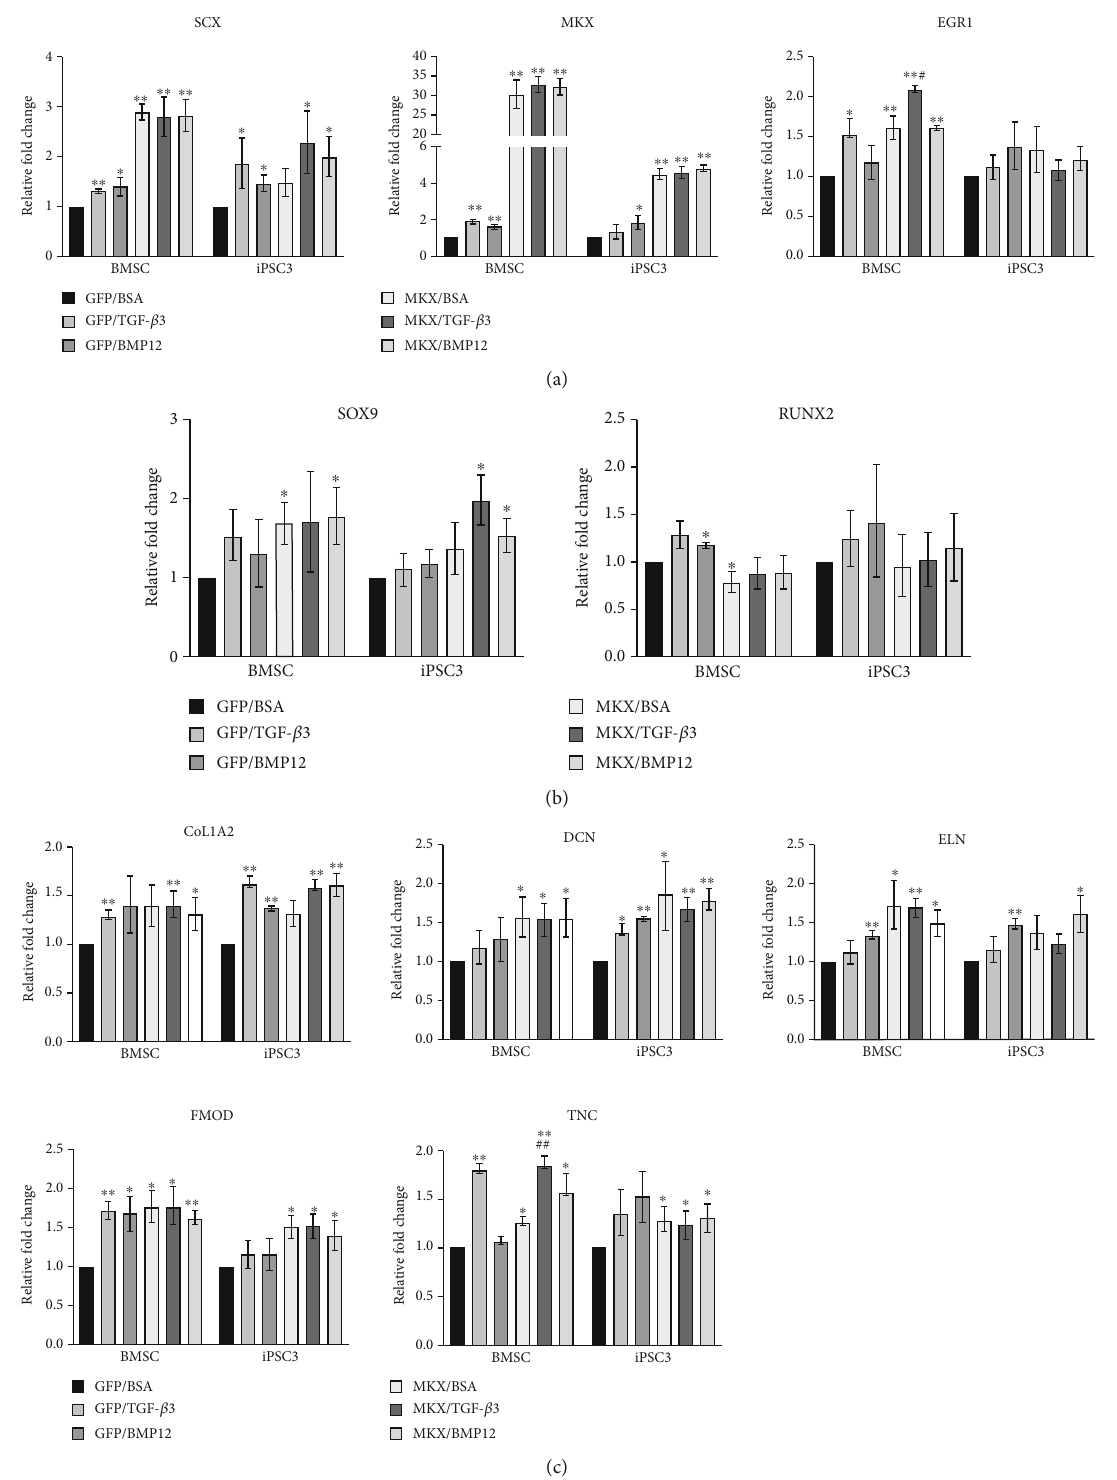
Figure 4: E ff ects of TGF- β 3 or BMP12 on tenogenic gene expression in MKX-overexpressing BMSCs and teno-iPSCs. Cells expressing GFP or equine Mohawk were treated with vehicle medium (GFP/BSA and MKX/BSA), TGF- β 3 (20 ng/mL, GFP/TGF- β 3 and MKX/TGF- β 3), or BMP12 (20 ng/mL, GFP/BMP12 and MKX/BMP12) for 5 days. cDNA was synthesized from total RNA, and expression of tenogenic transcription factors (a), SOX9 and RUNX2 (b), and tenocyte-related ECM genes (c) was determined by qPCR. Relative fold change for each group was calculated by comparison to the GFP-CTRL group. ∗ Data were compared to the GFP/BSA group, and # data were compared to the MKX/BSA